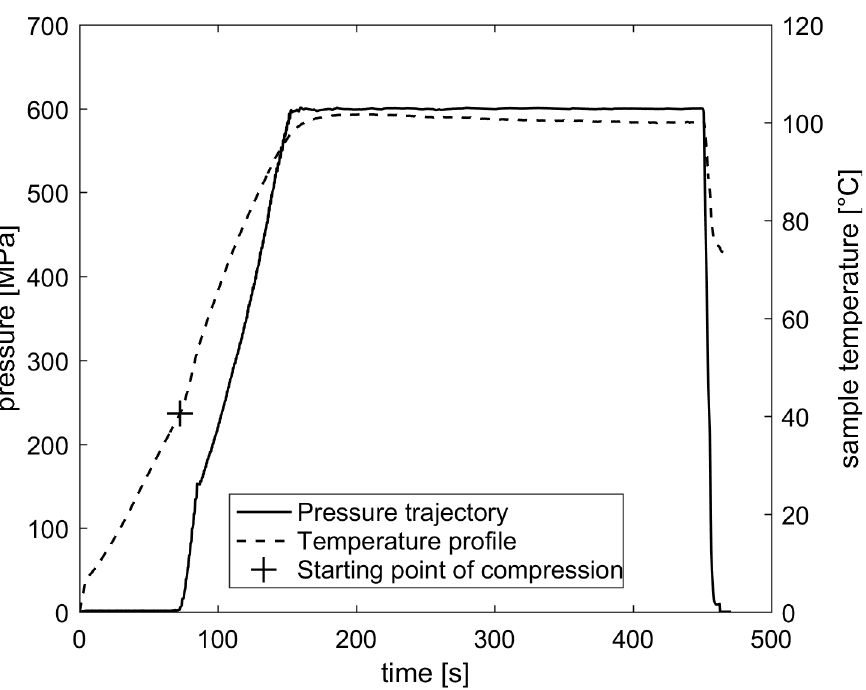
Fig 1. Typical temperature and pressureprofiles during HPT treatments. Exemplarily, pressure (dashed line) and temperature (solid line) profiles of a HPT treatment with a target pressureof 600 MPa, a target temperature of 100˚C and a pressure-holding time of 300 s are depicted.A cross marks the starting point of compression (40.5˚C, 72.5 s).